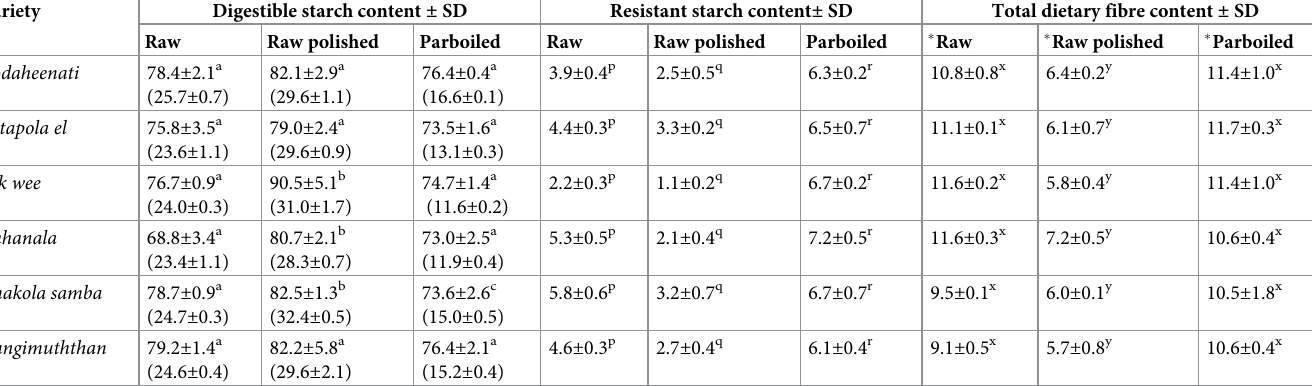
Table 2. Digestible starch, resistant starch and total dietary fibre (mean ± SD) contents of differently processed cooked rice flour g/100g in dry weight (fresh weight basis within parenthesis). Variety